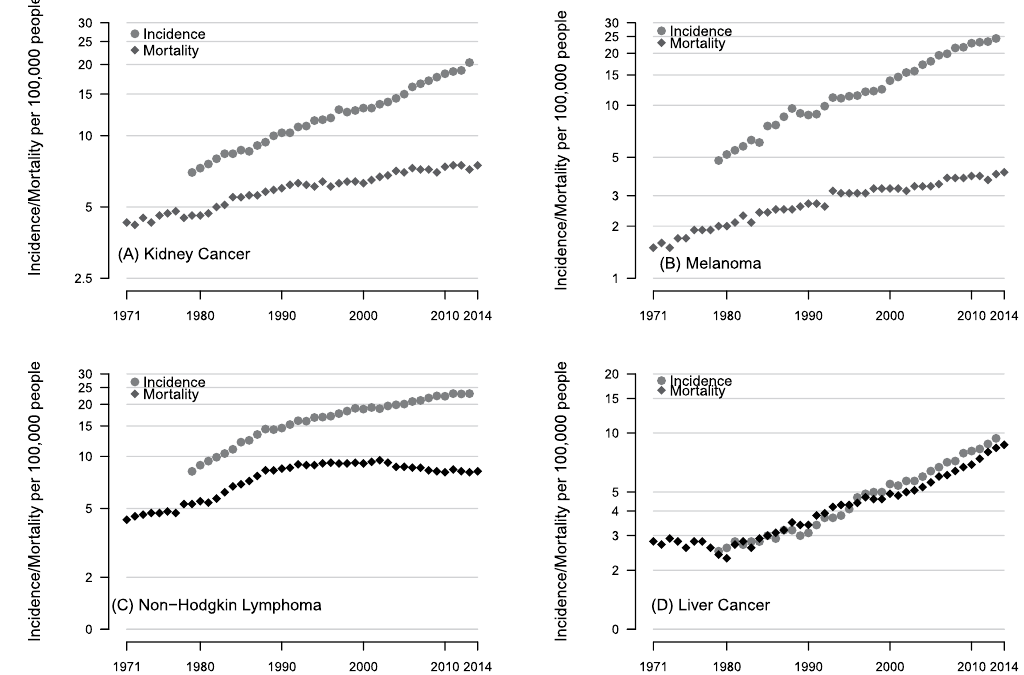
Figure 5. European age-standardised Incidence and cancer-specific mortality (per 100,000) for ( A ) kidney, ( B ) melanoma, ( C ) NHL and ( D ) liver cancer. Figures are for men and women